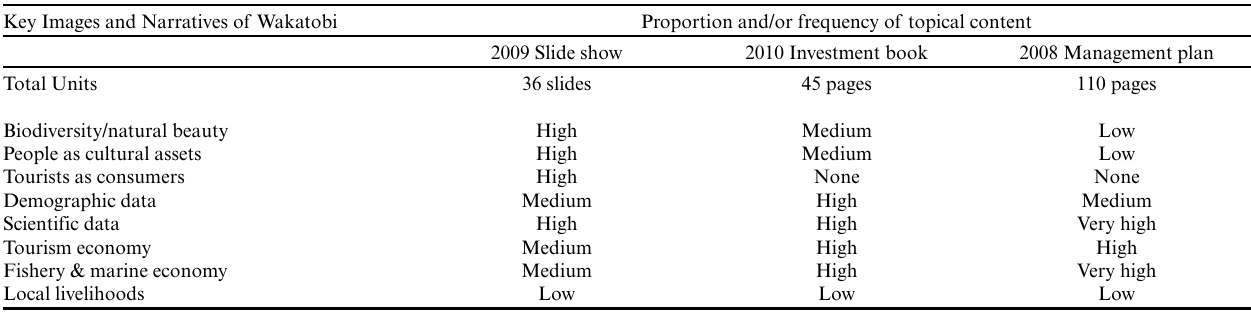
Table 1 . Content in three communication instruments in Wakatobi National Park (WNP). Key Images and Narratives of